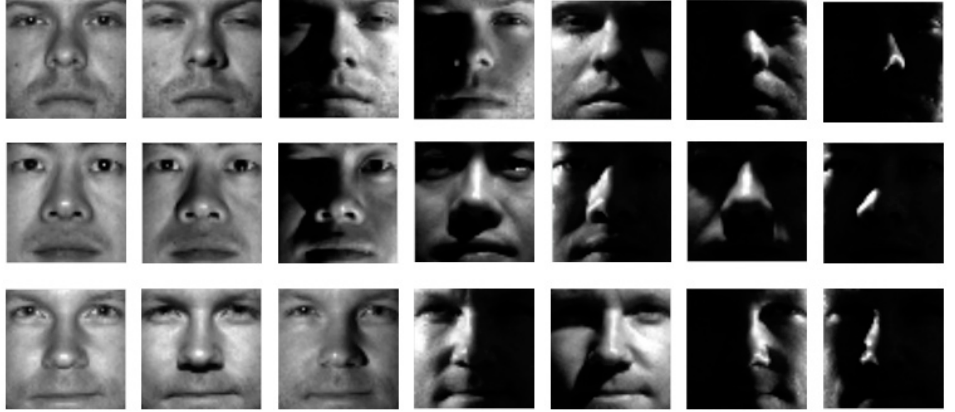
Figure 2. Some samples of the Yale-B database.